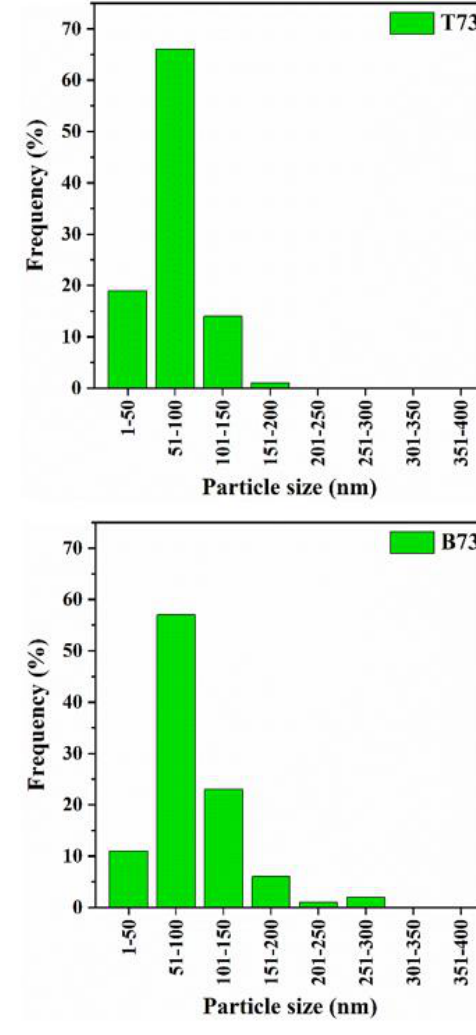
Figure 4. confirmed the effective role of CNF in reducing the particle size of zeolite Y in ball milling. The use of CNF as damping/protection material created a larger area of contact for the zeolite Y particles during the ball milling which sig- nificantly improved the effectiveness of the ball milling process and prevented the formation of flakes/particles